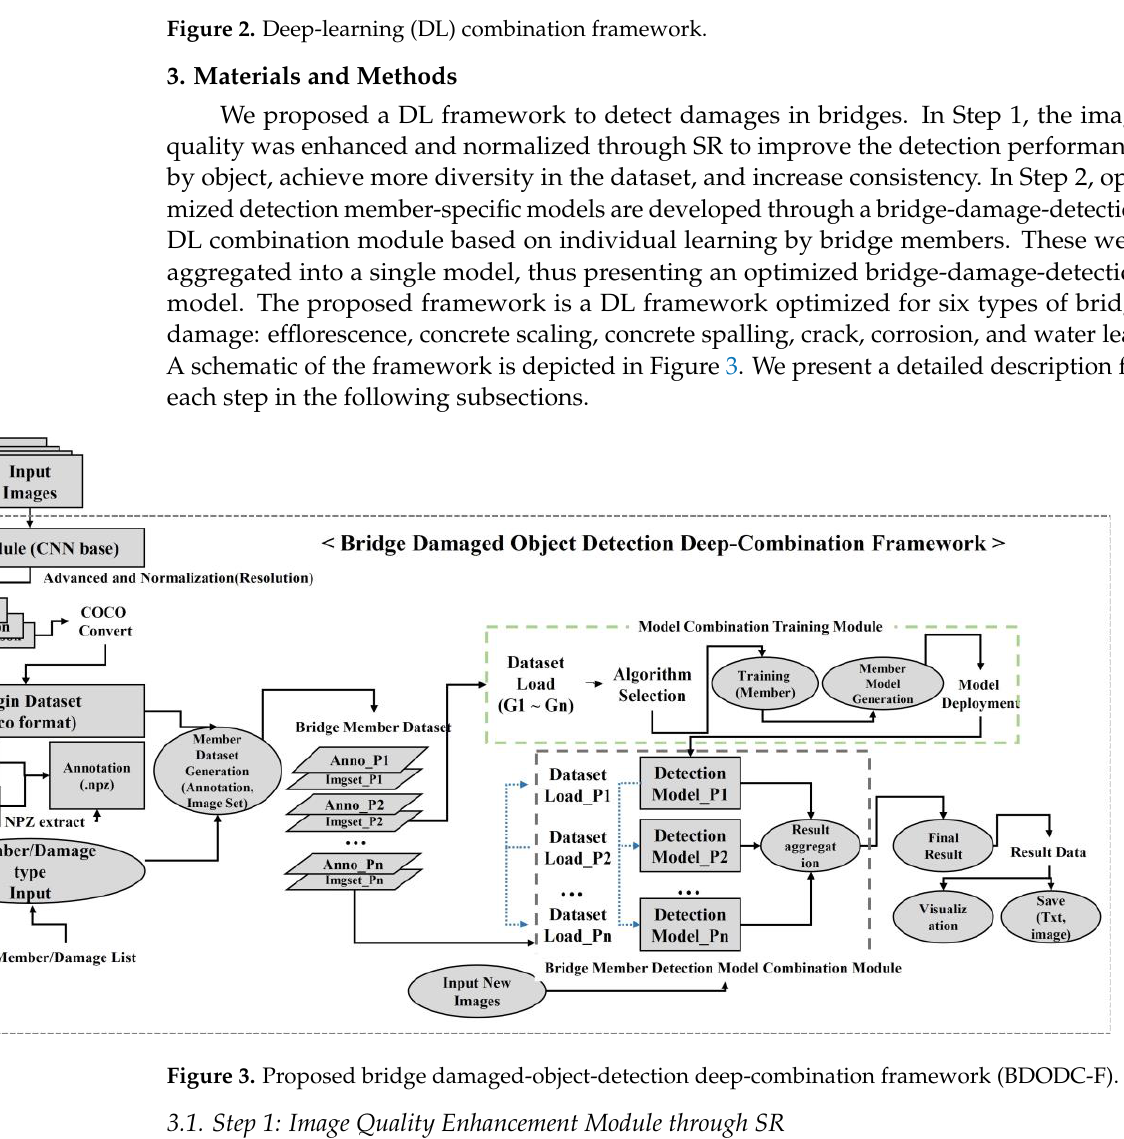
Figure 3. Proposed bridge damaged-object-detection deep-combination framework (BDODC-F).